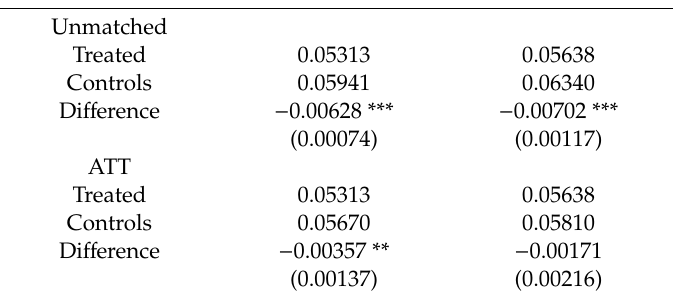
Panel B: Treatment E ff ect of Environmental Performance on